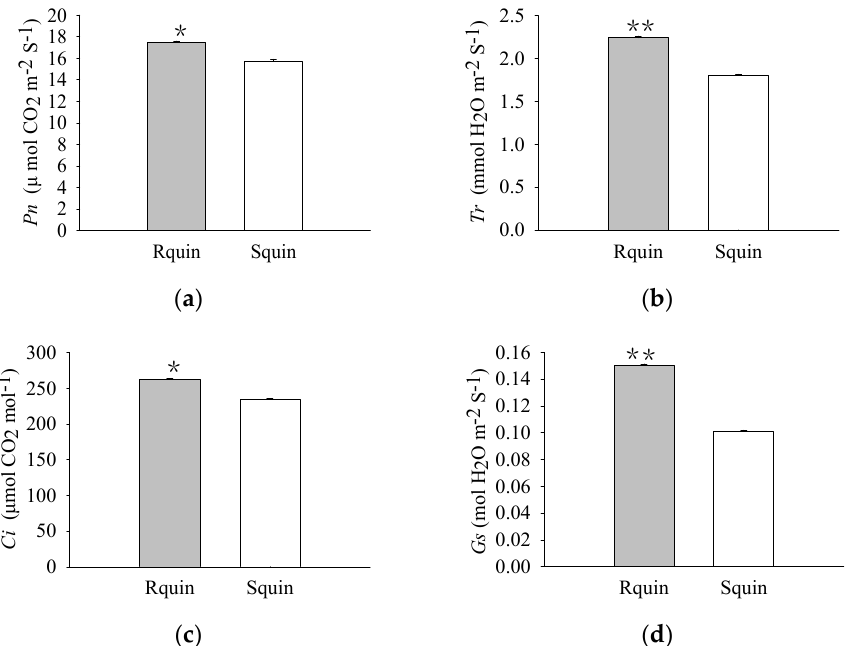
Figure 3. The chlorophyll (Chl) content of quinclorac-resistant (Rquin) and -sensitive (Squin) E. crusgalli with quinclorac treatment. ( a ) Chl a content; (b) Chl b content; (c) Chl (a+b) content. * rep- resents a statistically significant difference ( p < 0.05), and ** represents a statistically significant dif- ference ( p < 0.01).